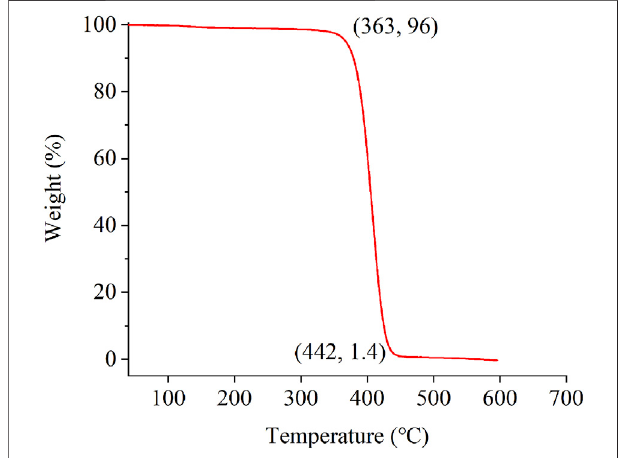
FIGURE 3 | Thermogravimetric analysis curve of the powder sample of the modi fi ed polystyrene latex